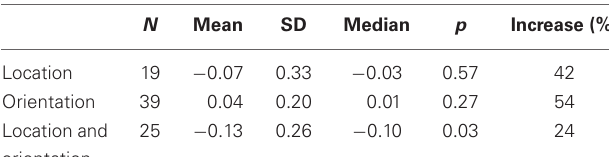
compared to trial t − 2 for the three types of receiver